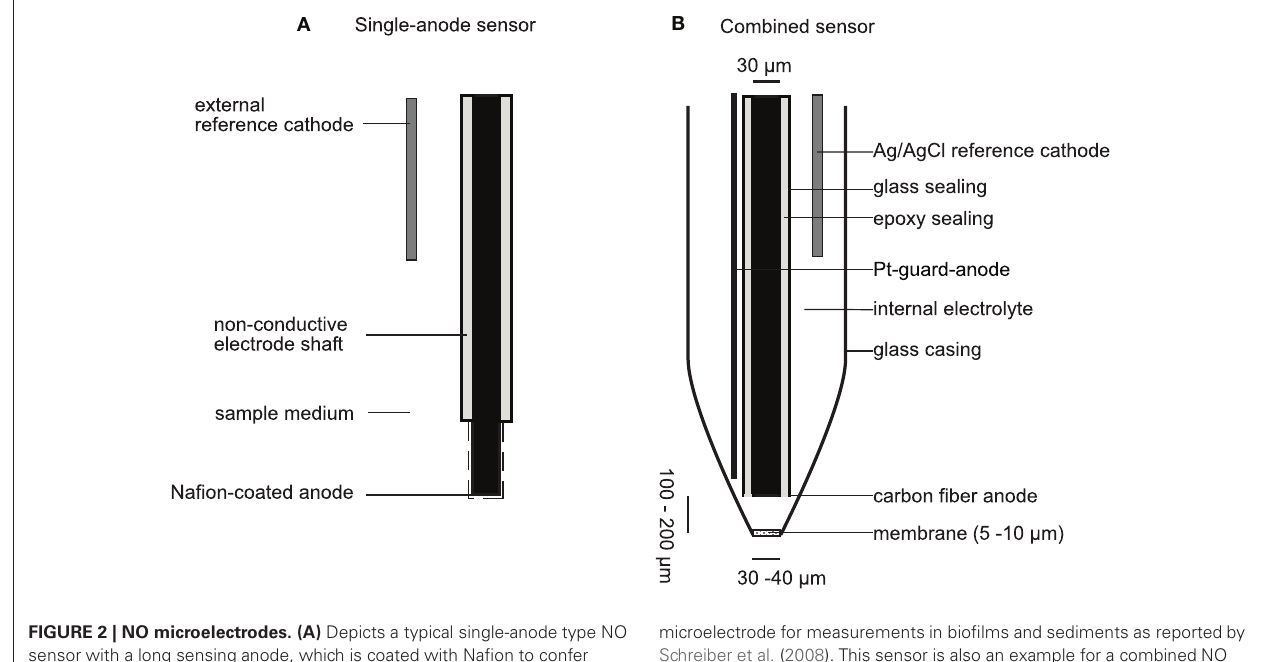
microelectrode for measurements in biofilms and sediments as reported by Schreiber et al. (2008). This sensor is also an example for a combined NO sensor (Clark-type) where sensing anode and reference cathode are separated from the sample medium by a gas permeable membrane. Drawing is not to